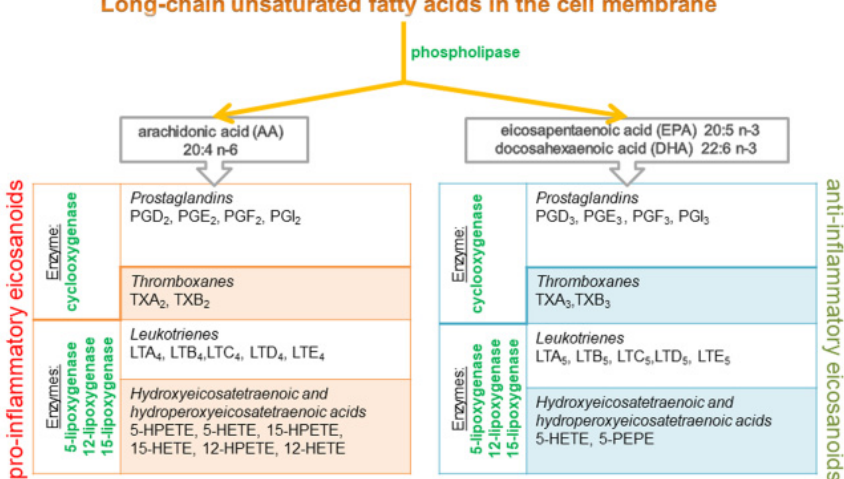
Figure 6. Two pathways of eicosanoid synthesis from fatty acids. Eicosanoids derived from omega-6 fatty acids (AA) are generally classified as